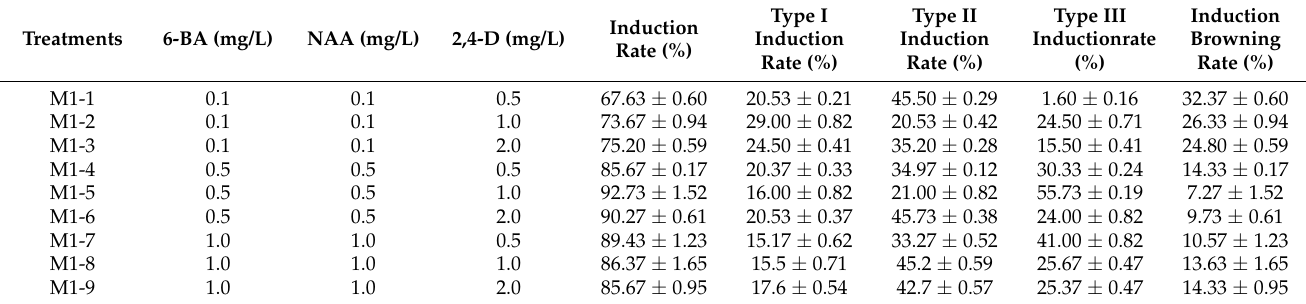
Table 3. Effect of PGRs on embryogenic callus induction from konjac leaves. Treatments